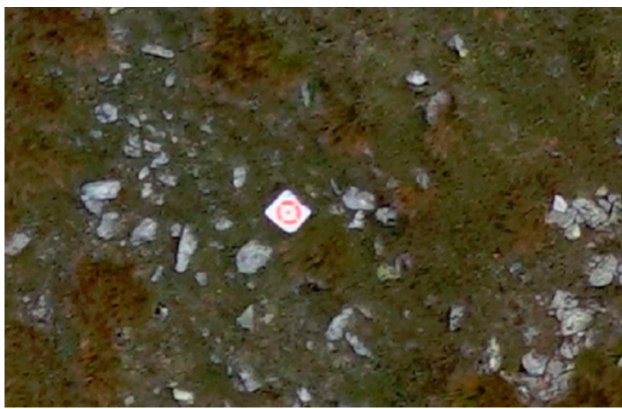
Figure 5. A control point on the image taken from the UAV (source: authors’ own study). Control points and check points were measured with the real-time network (RTN) GNSS method referenced to a network of reference stations NadowskiNET or the real-time kinematic (RTK)